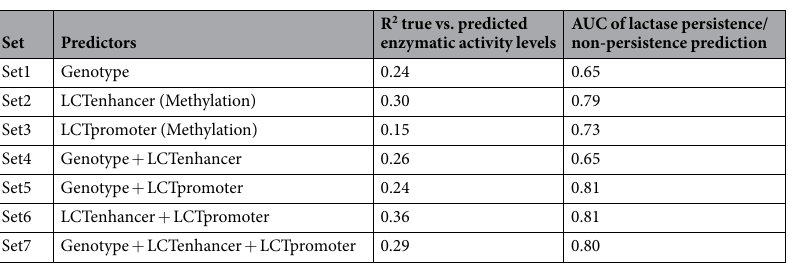
Set7 Genotype + LCTenhancer + LCTpromoter 0.29 0.80 Table 3. Prediction performances for enzymatic activity levels and lactase persistence/non-persistence phenotype using different sets of predictors: LCT enhancer and promoter are averaged methylation levels in their respective location based on DNA methylation measurements from pyrosequencing. The − 13910C > T genotype consists of categories CC, C/T and